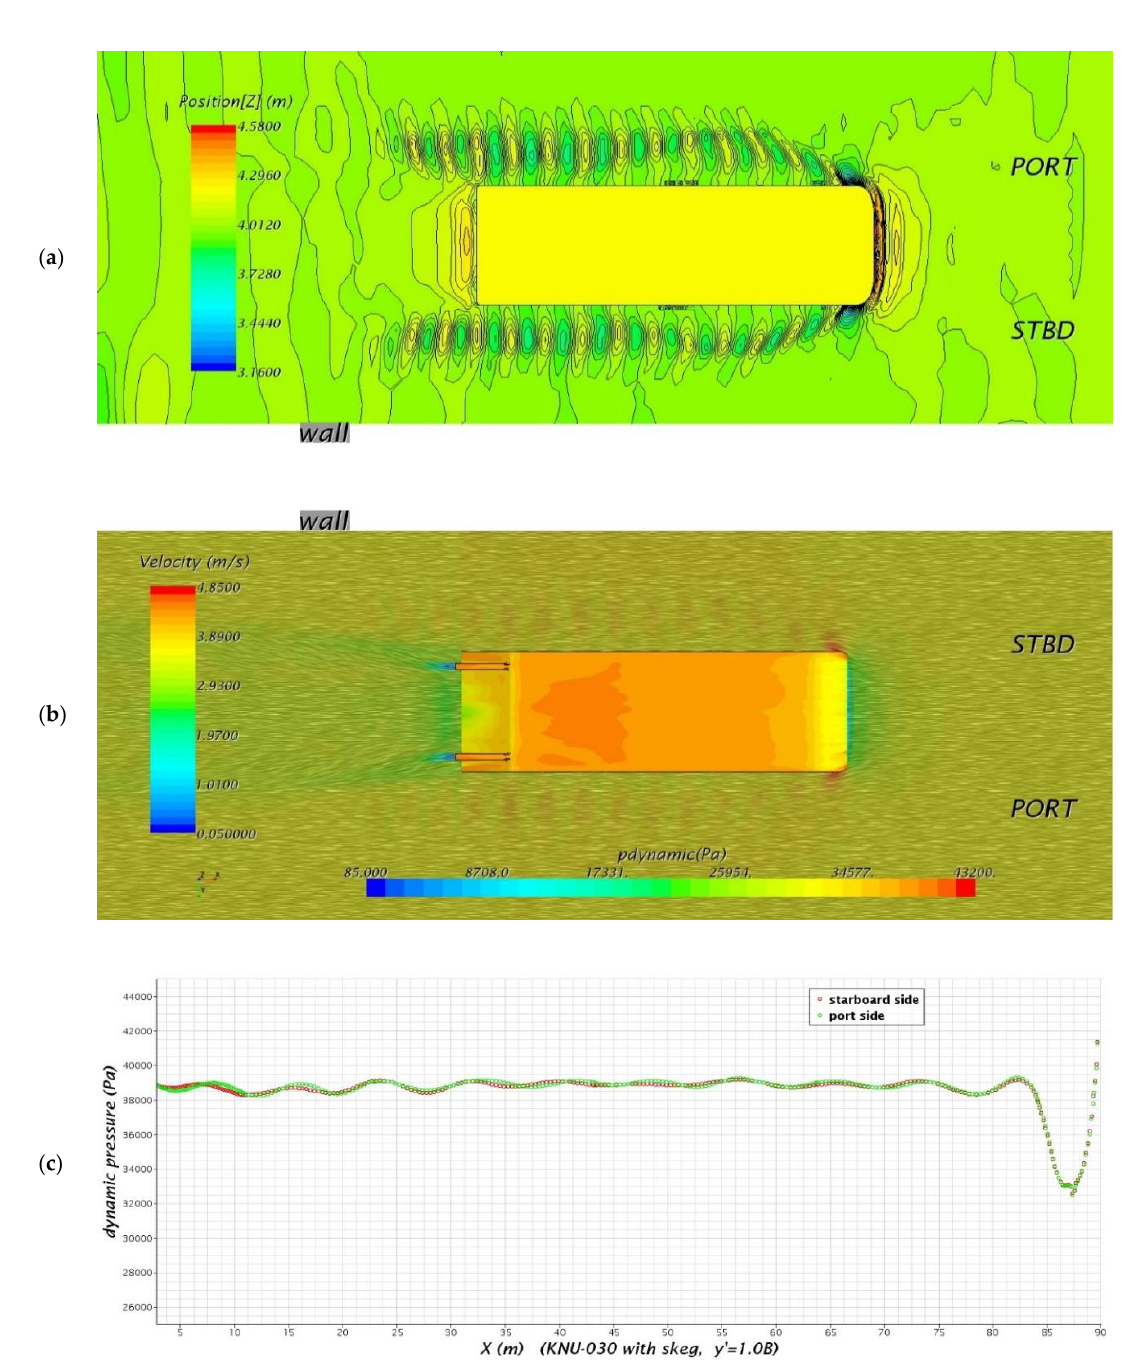
Figure 11. Simulation results for KNU-030 at y′ = 1.0 B : ( a ) wave pattern; ( b ) velocity field with line integral convolution and hydrodynamic pressure distribution on the bottom; and ( c ) hydrodynamic pressure on the starboard and port side.